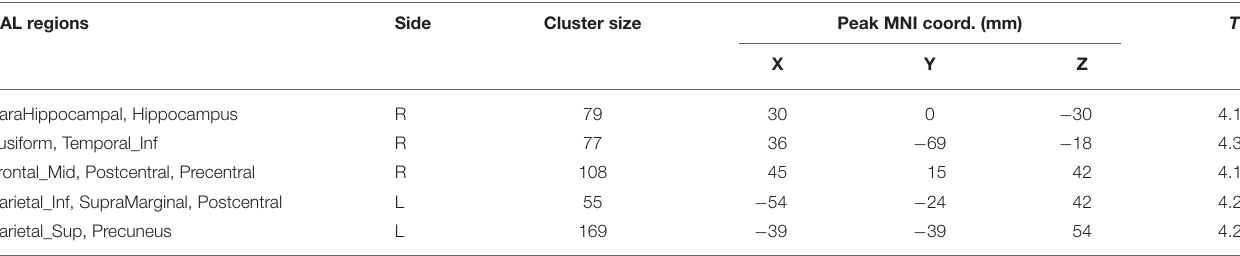
TABLE 4 | Differences in HE between